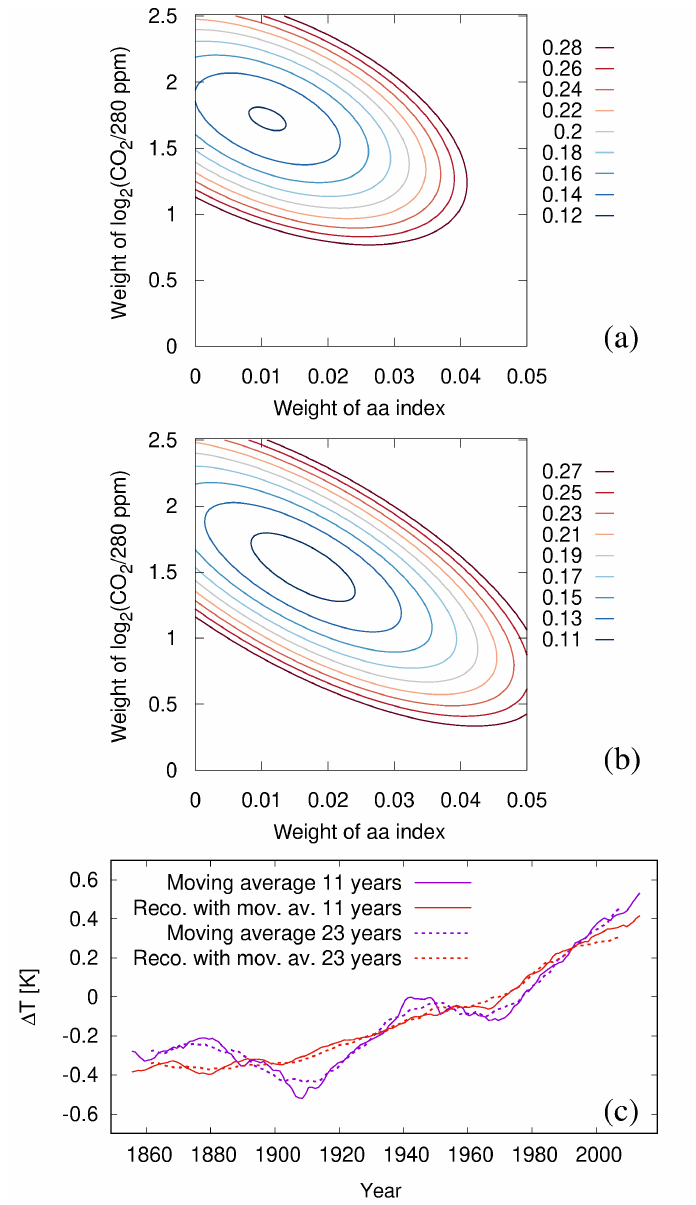
Figure 4. Regression analysis for the full data (with end year 2018). ( a ) FVU in dependence on w aa and w CO for MAW = 11years, with FVU min = 0.107 reached for w aa = 0.011K/nT and w CO 2 ( b ) The same for MAW = 23years, with FVU min = 0.102 reached for w aa = 0.0162K/nT and = 1.54K. ( c ) The 11-year and 23-year moving averages for the original ∆ T (purple) and for the w CO 2 reconstructed ∆ T (red) when using the optimized values of w aa and w CO